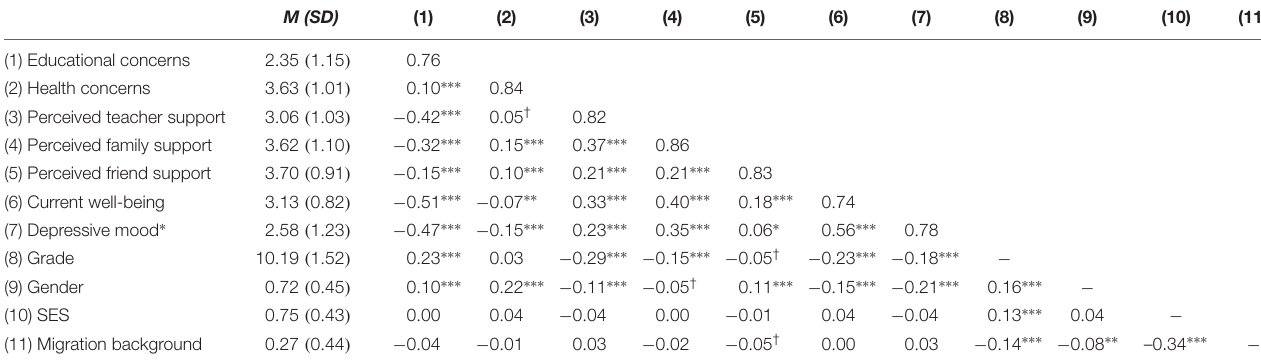
TABLE 1 | Descriptive statistics of the components of the resilience profiles and the control variables ( N =